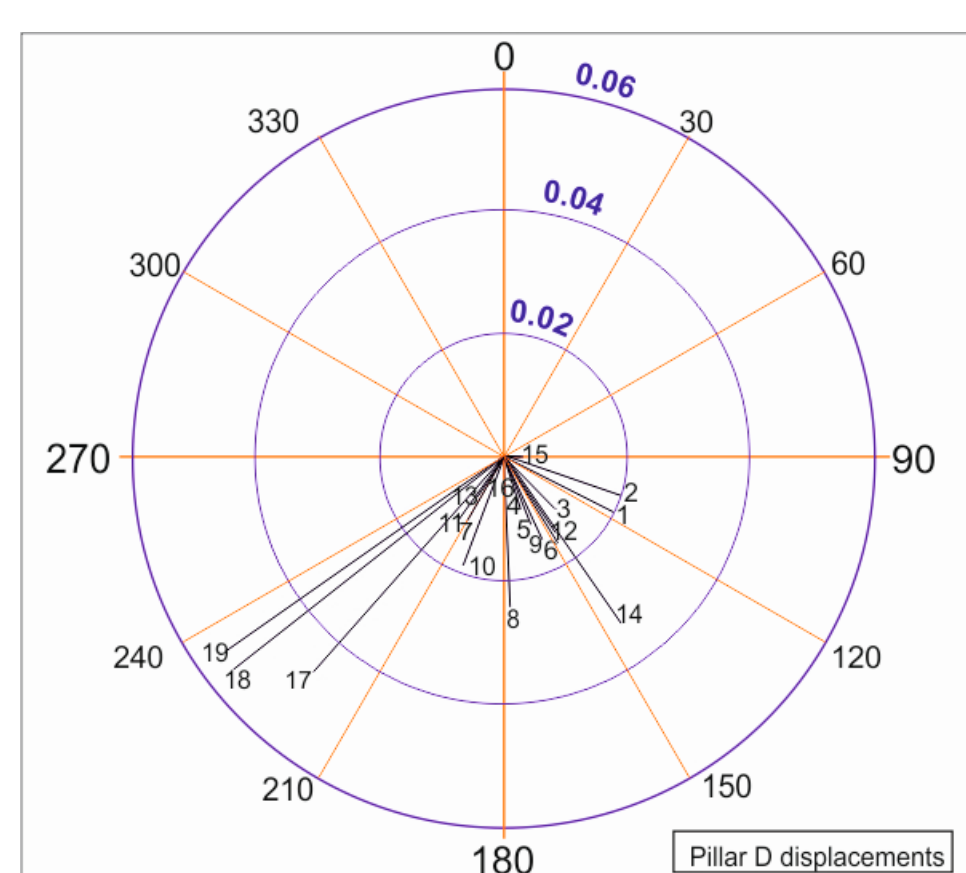
Figure 6. The results of the repeated GNSS measurements as displayed in a vector format in a three-axis diagram.